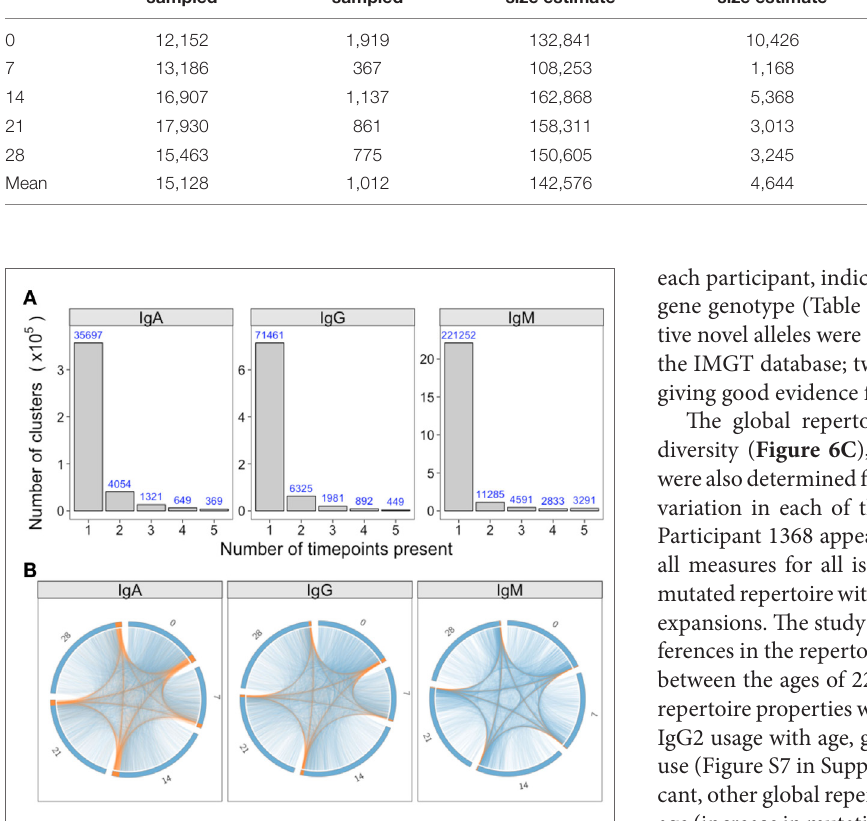
FigUre 4 | Persistence of clusters over time . (a) For samples of each isotype from participant AF01, the total number of clusters across all timepoints was determined, and the number of these present at different number of timepoints calculated. (B) Using the same data as A, circos plots were constructed to show the clusters present on different days. Each arc represents a different day, and clusters are ordered clockwise by abundance, with the abundant clusters colored orange, and the rare clusters colored blue. Lines join clusters present at more than one